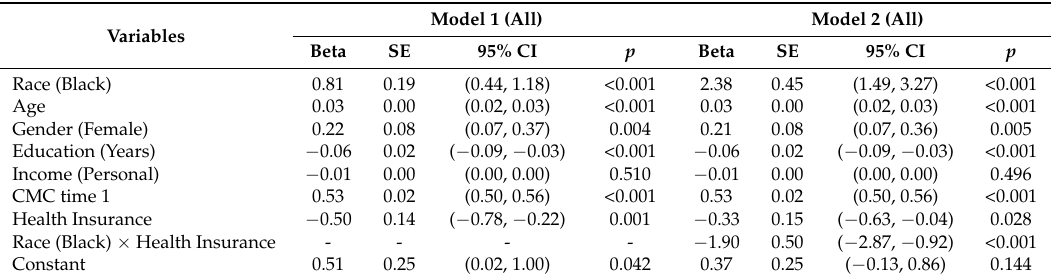
Table 2. Linear regression in the pooled sample based on the association between healthcare insurance and incidence of chronic medical conditions (CMC) over 10